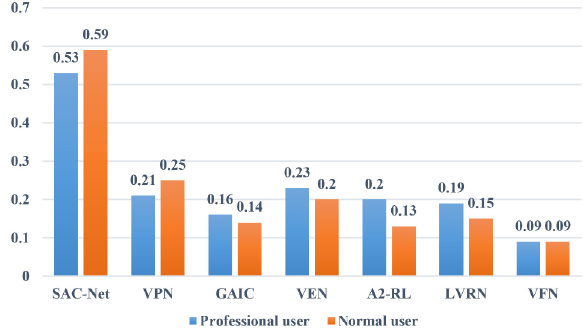
Fig. 9 User study result on multiple-object images using the SACD and CPC dataset test sets.